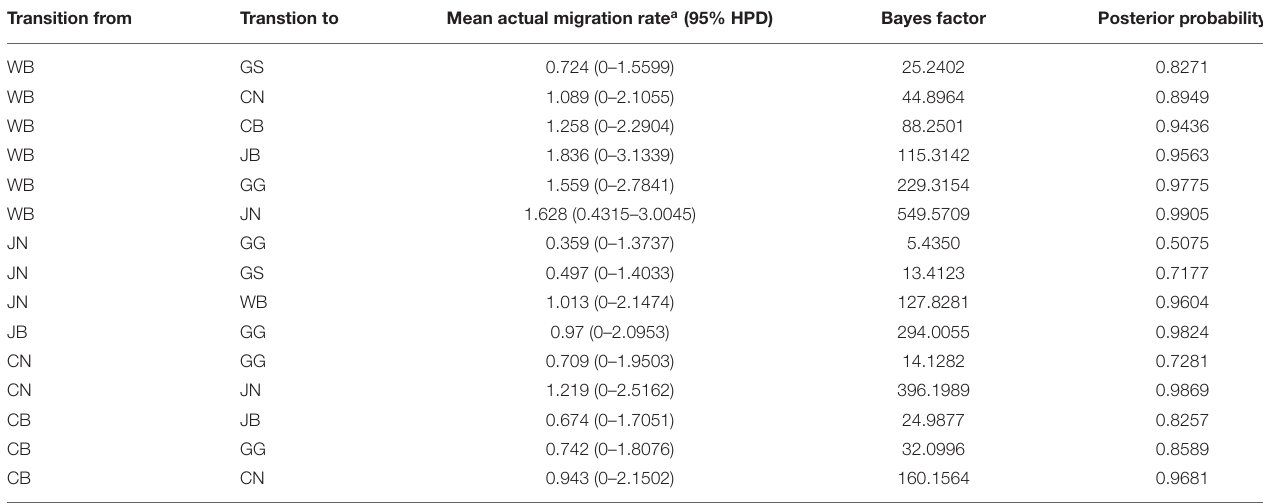
TABLE 4 | Viral transition of discrete traits (based on HA gene sequences) between different regions (WB, JN, JB, GG, GS, CB, and CN) in South Korea. Transition